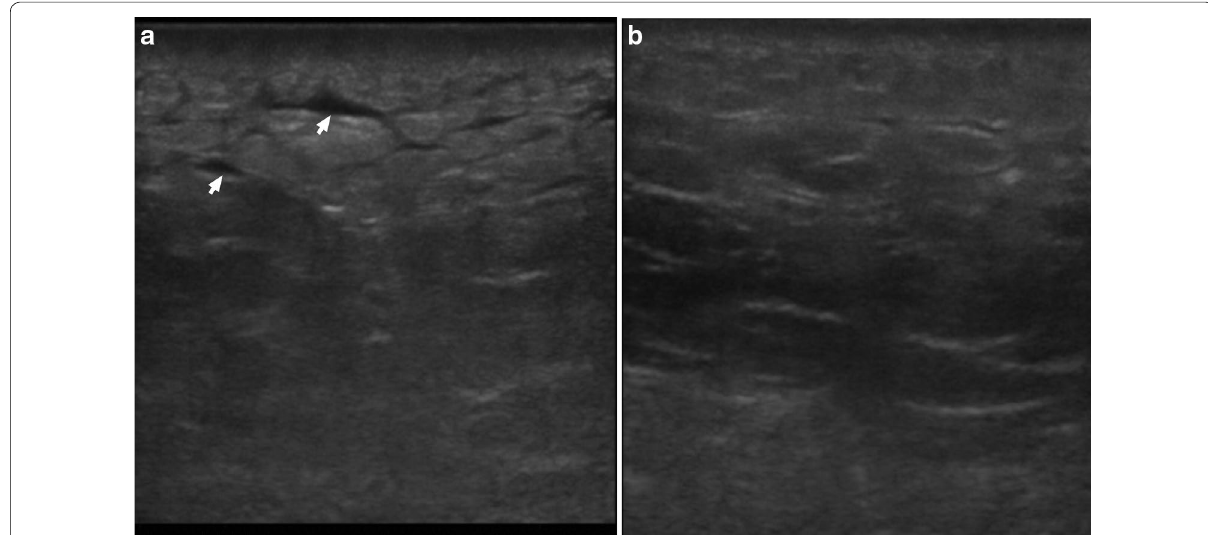
Fig. 4 Point-of-care ultrasound scan of the affected left gluteal soft tissue 4 days after admission ( a ) and 8 days after admission ( b ) using a 15–6 MHz linear probe. These images show the progression of the sonographic appearance of NSTI, initially with accumulation of fluid in the subcutaneous tissue (arrows), giving it a “cobblestone” appearance and a progressive return to the normal architecture of the subcutaneous tissue